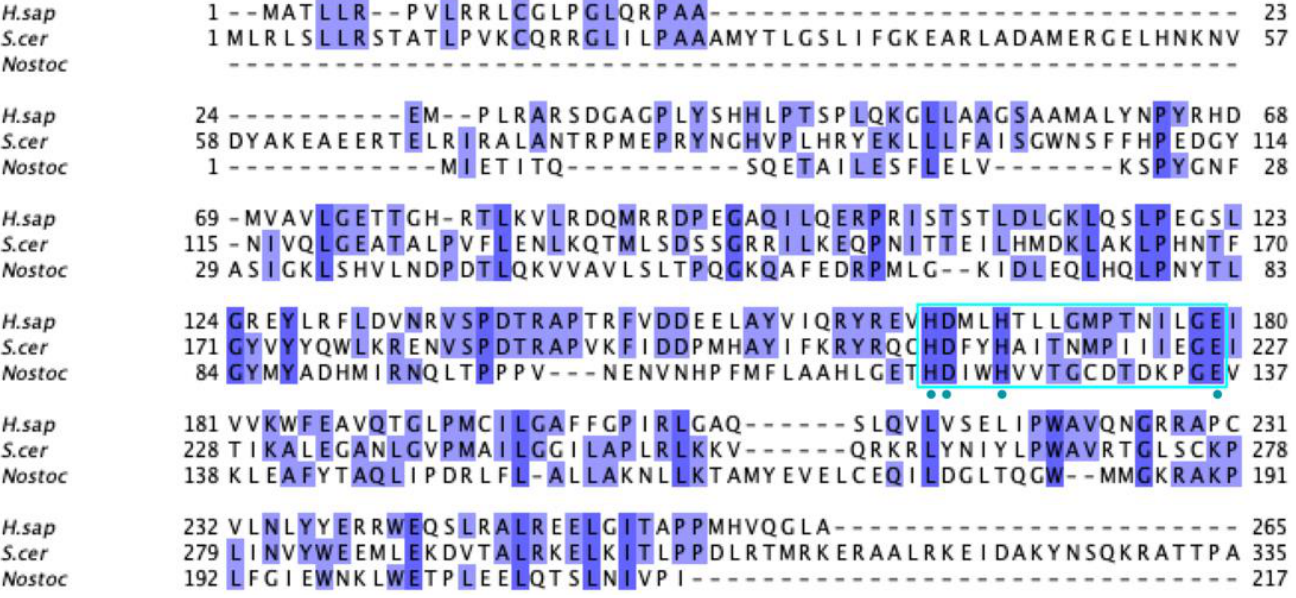
Figure A2. Multiple sequence alignment of H. sapiens COQ4, S. cerevisiae COQ4, and Nostoc sp. homolog Alr8543 (NCBI accession number: WP_010999537.1). Metal-liganding motif is boxed in cyan, and residues in Alr8543 (H120, D121, H124, and E136) that act to ligand the Mg 2+ ions are marked with blue dots.